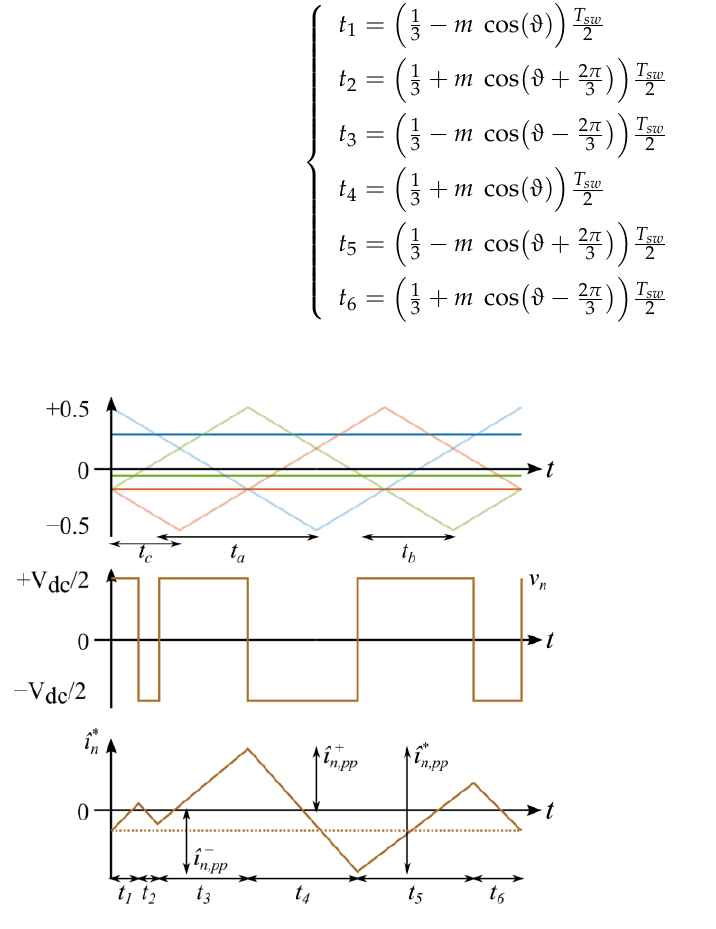
Figure 8. Modulating signals with three interleaved carriers cr a , cr b , and cr c ( top ), instantaneous phase voltages and their sum v n ( middle ), and neutral current ripple ˆ i n ( bottom ) in the period T sw in phase voltages and their sum 𝑣 𝑛 ( middle ), and neutral current ripple 𝑖̂ 𝑛 ( bottom ) in the period T sw in case of balanced PWM. case of balanced